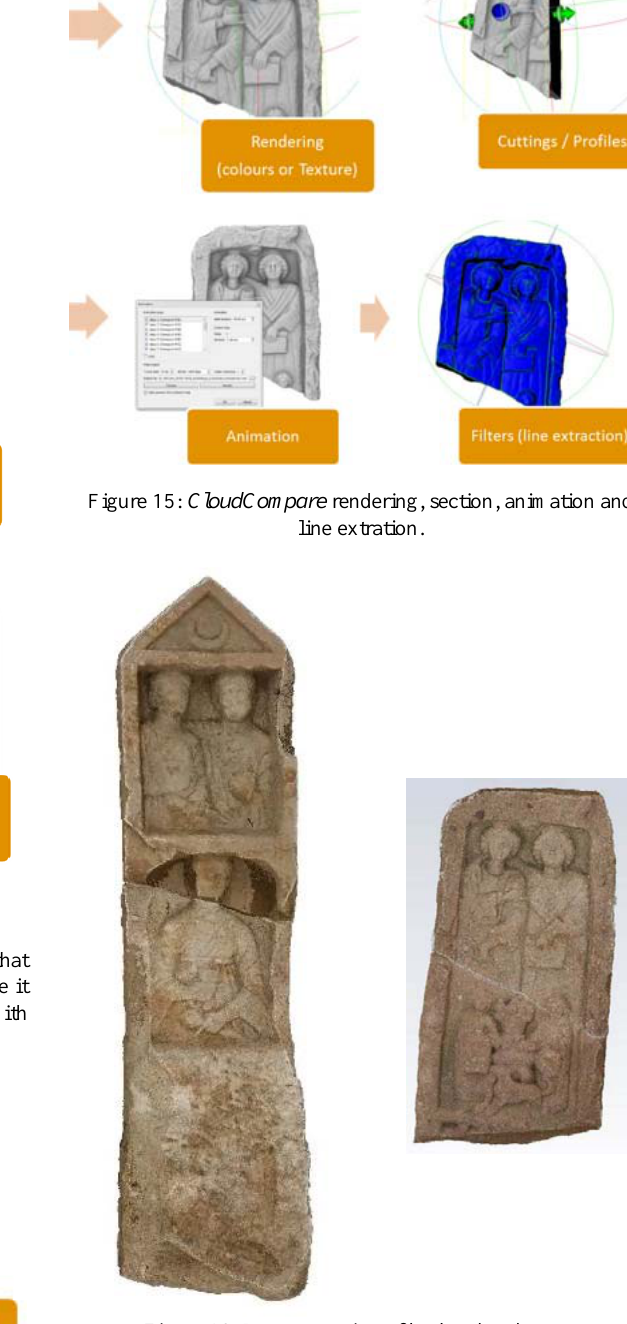
Figure 16: Reconstruction of broken